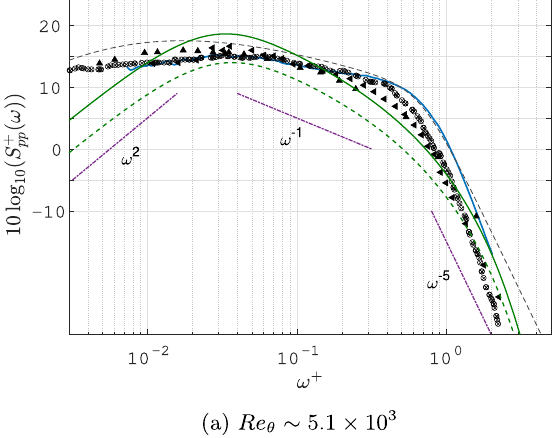
Figure 5. Mean velocity pro fi les under favourable pressure gradient conditions: comparison between numerical data from Cohen and Gloerfelt [5] (dash) and model (solid line) at Re + = 745 and b P = (cid:2) 1.23 (green), and between experimental data (circles) and model (solid line) at Re + = 1850 and b (cid:2) 6.0 P =